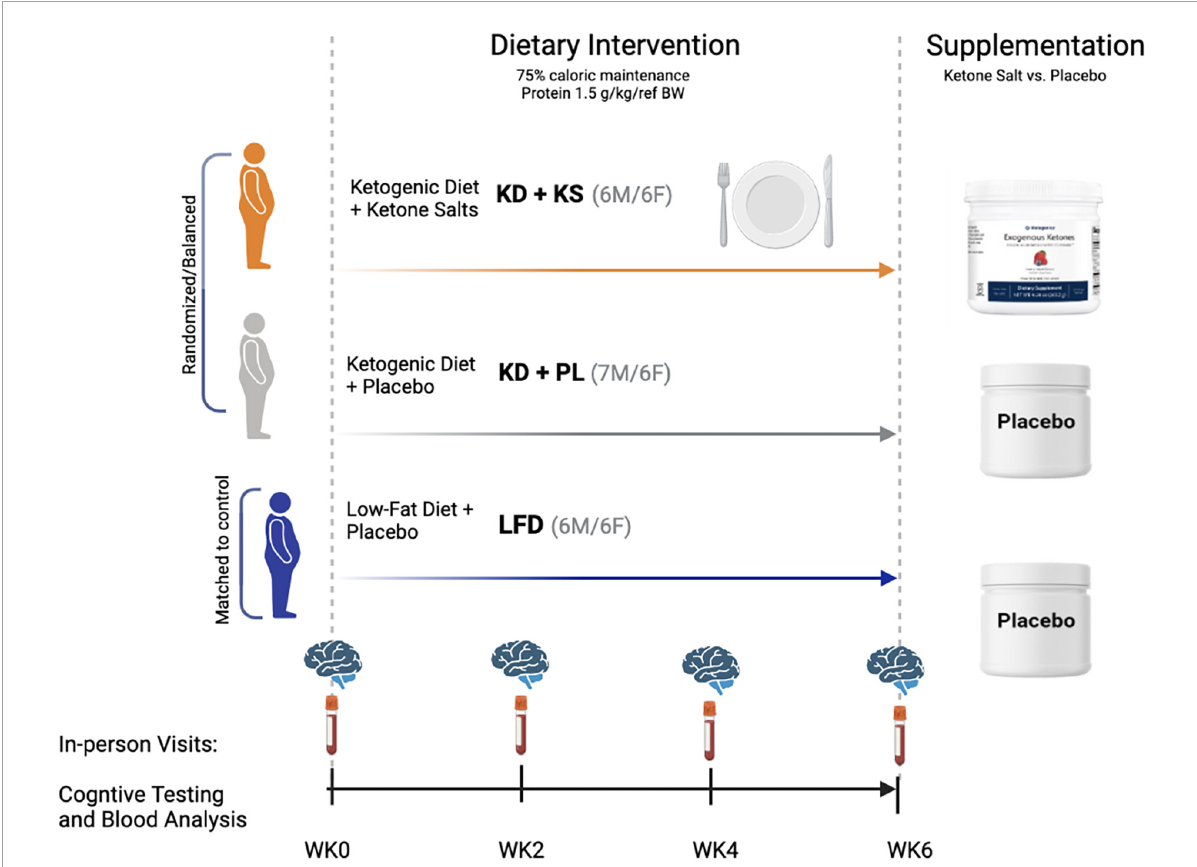
FIGURE1 Experimental design and macronutrient breakdown for both ketogenic (KD) and low-fat (LFD) diet